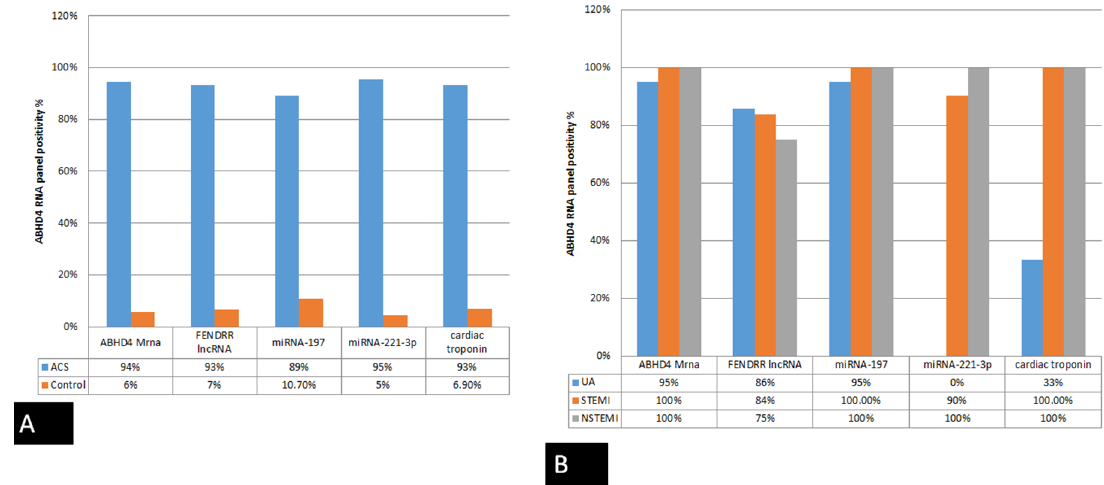
Figure 3. Bar chart shows the positivity rate of the studied parameter: ( A ) between ACS patients and control (non-cardiac and healthy controls), and ( B ) the diagnostic value of the studied parameters in discriminating UA from STEMI and NSTEMI.